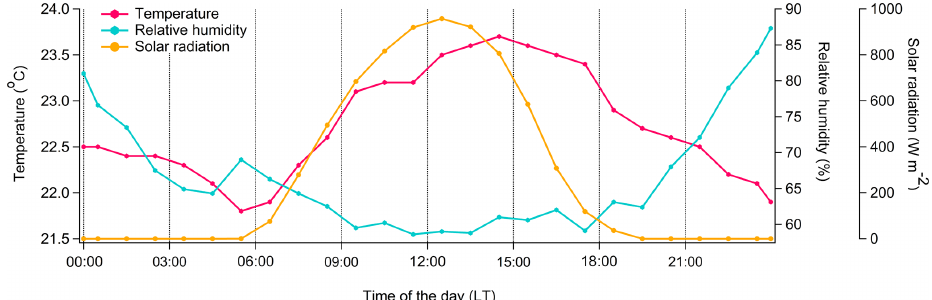
Figure 2. Diurnal evolution of the temperature (magenta line), relative humidity (light blue line), and solar radiation (orange line), respec- tively, during the “representative” new particle formation event observed at Finokalia on 29 August